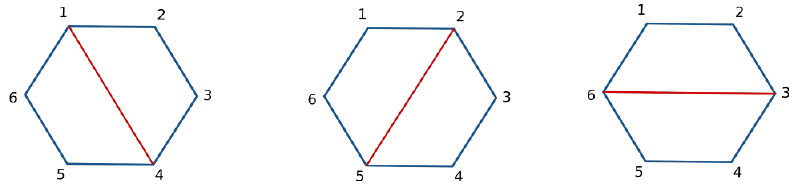
Figure 8 . The 3 different planar channels for 6-point